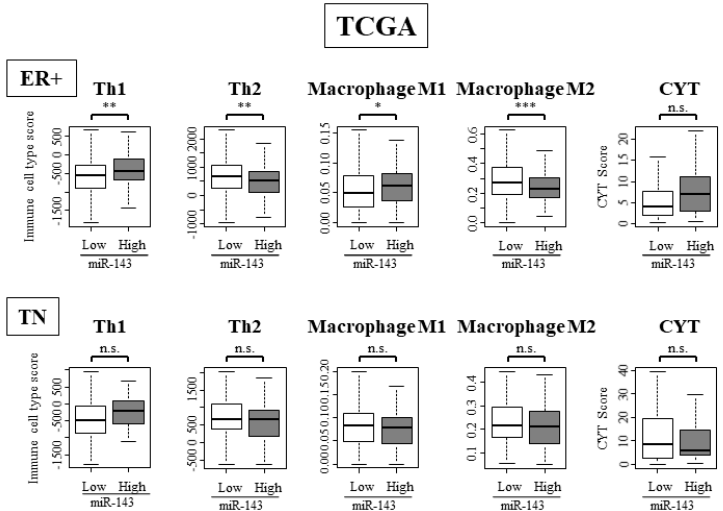
Figure 7. miR-143 high tumors were associated with high infiltration of anti-cancer immune cells. Immune cell composition within a tumor and CYT score of ER positive and TN subgroup. * p < 0.05; ** p < 0.01; *** p < 0.001; n.s., not statistically significant. ER + , estrogen receptor positive; TN, triple negative.